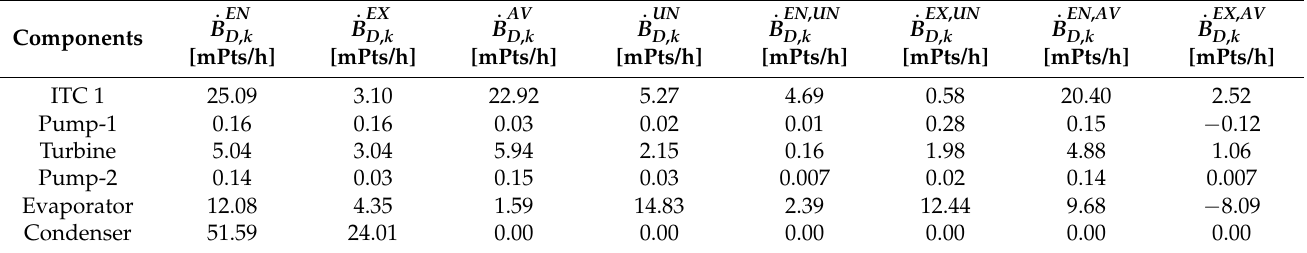
Table 17. Associated environmental impact by exergy on each component using copper as a material.